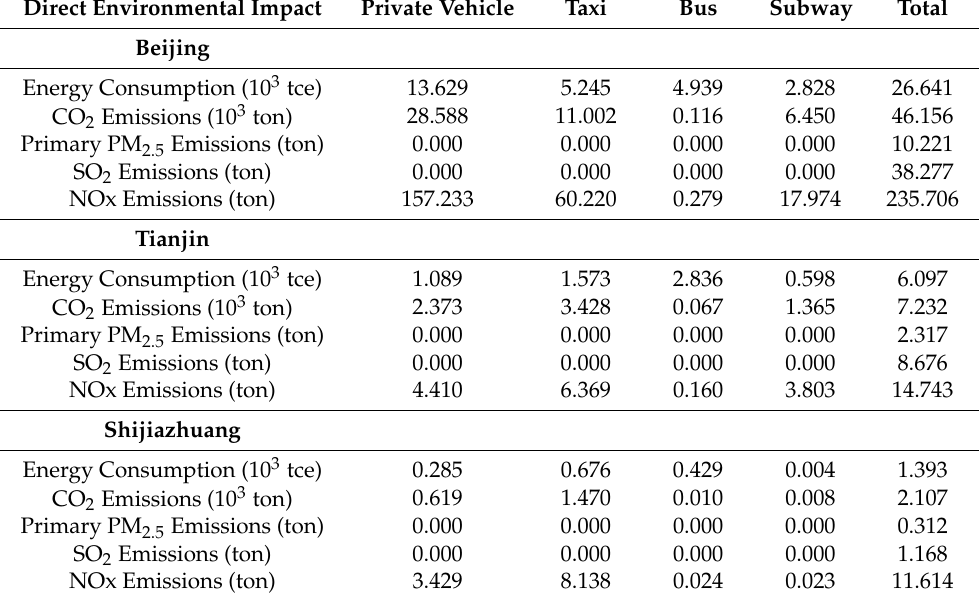
Table 3. Annual energy consumption and emissions using original travel